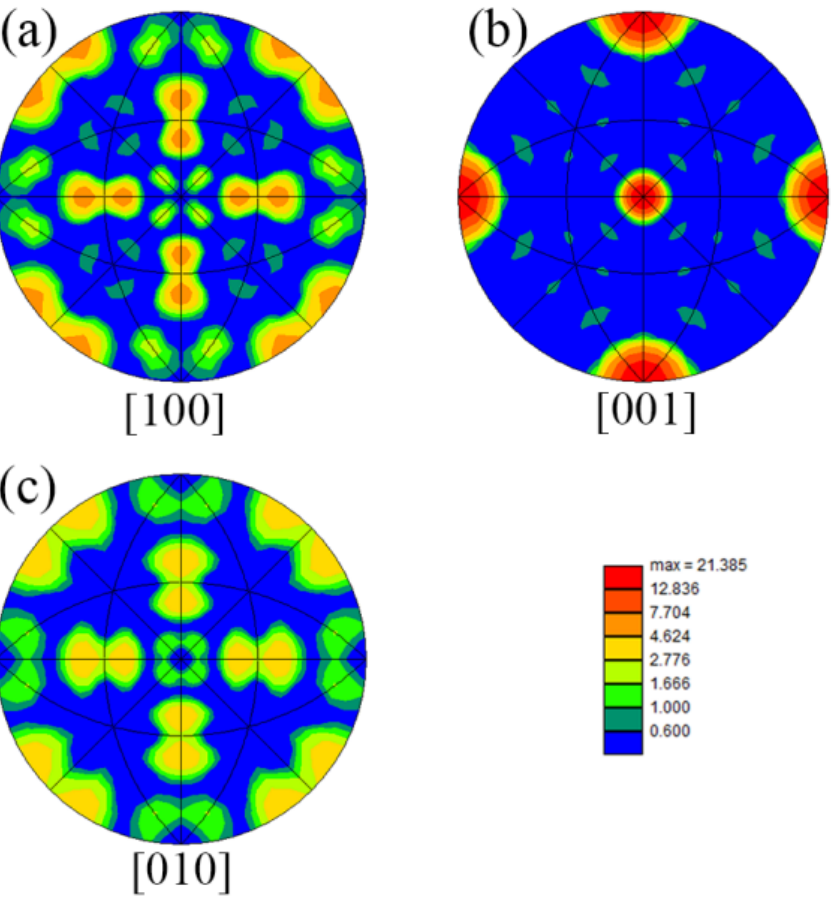
Figure 6. Inverse polar diagram of TLP-diffusion-bonded joint using low-B interlayer. ( a ) [100] orientation; ( b ) [001] orientation; ( c ) [010] orientation.